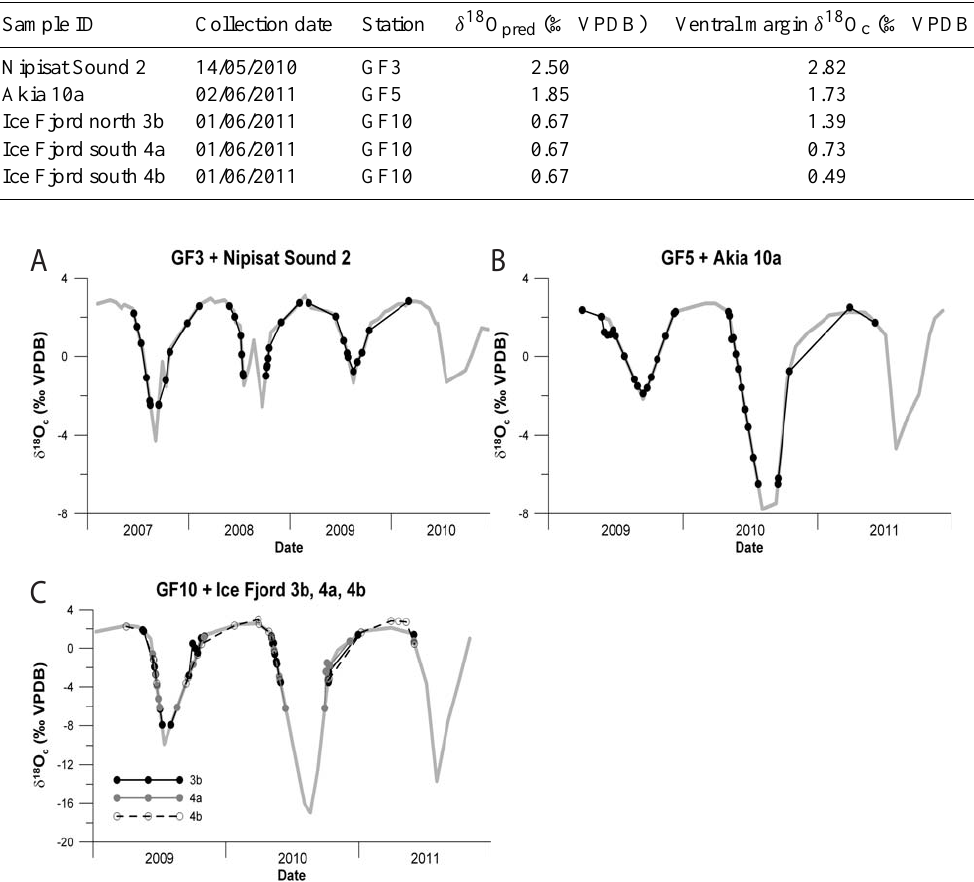
Fig. 6. Comparison of δ 18 O pred and δ 18 O c values for three different sites. In addition to a winter growth cessation that is visible in most shells, a summer growth cessation appears to occur when δ 18 O w values (i.e. salinity) become too